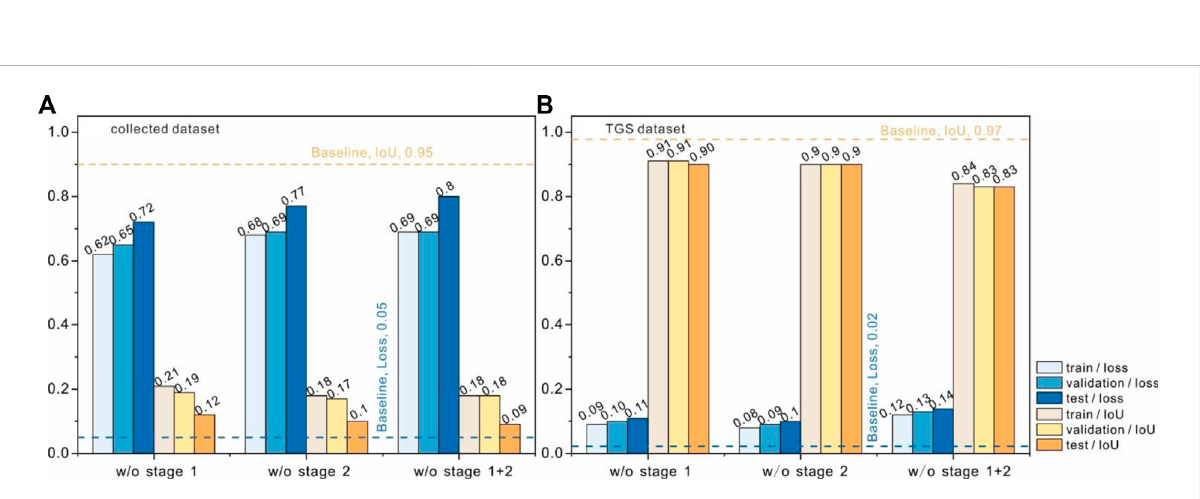
FIGURE 16 The performance of models without inversion (A) collected dataset; (B) TGS